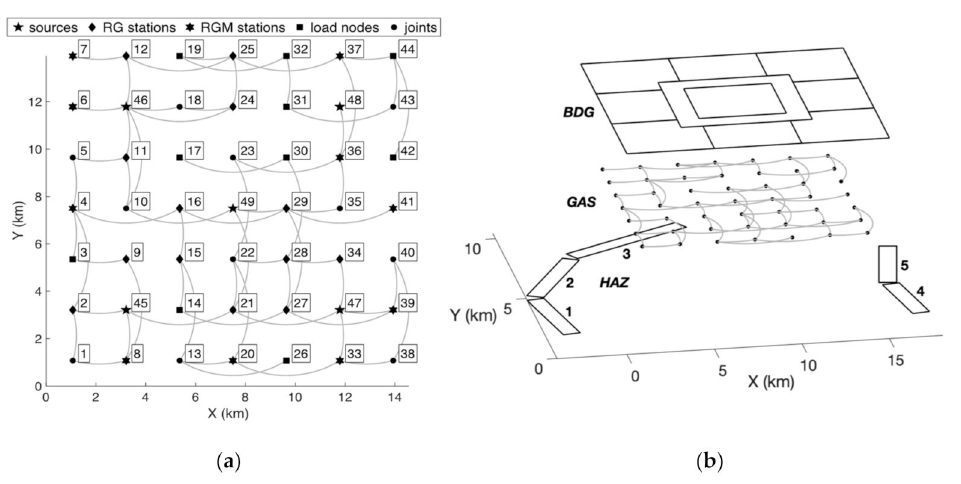
Figure 5. The synthetic city used as case-study. ( a ) Sketch of the realistic gas network with multiple pressure levels; ( b ) the gas network together with the building and hazard